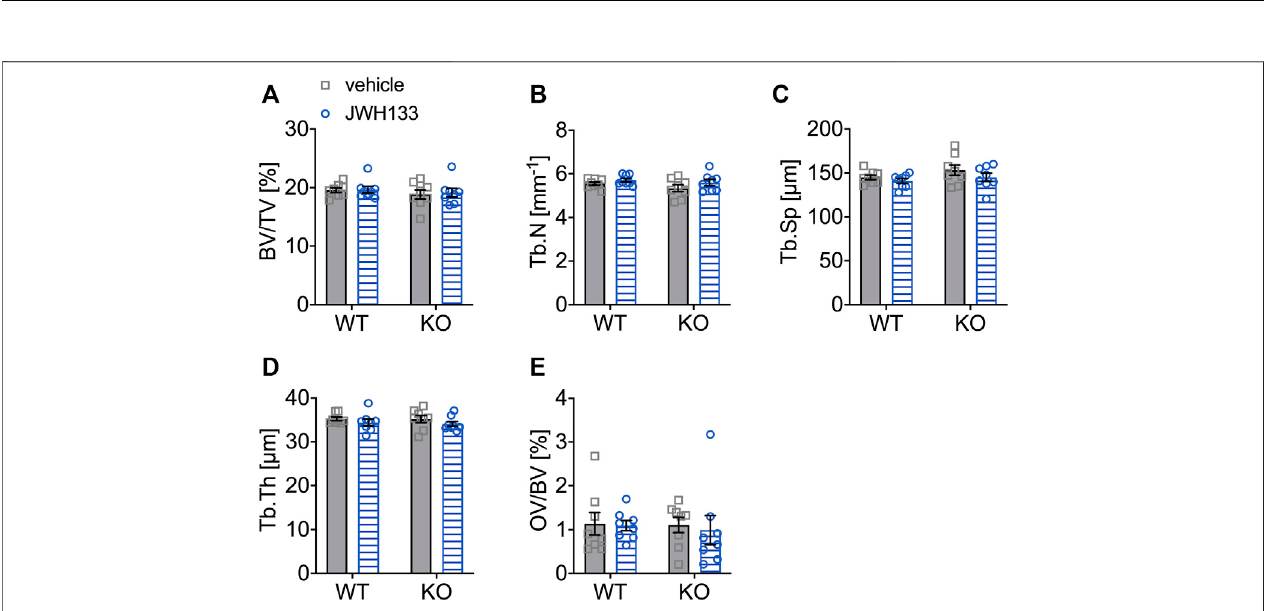
FIGURE 8 | Structural bone parameters were not affected by a 4-week treatment with JWH133 in aged mice. (A) Bone volume per tissue volume (BV/TV) was similar between WT and p62 KO mice and showed no effect of treatment. (B) Trabecular number (Tb.N) was comparable between genotypes and treatment. (C) Trabecular spacing (Tb.Sp) showed no difference between genotype or treatment. (D) Trabecular thickness (Tb.Th) was comparable for genotype and treatment. (E) Osteoid volume per bone volume (OV/BV) was similar in p62 KO and WT mice and not in fl uenced by the treatment with JWH133. Data were analyzed by using ordinarytwo-wayANOVA.Allerrorbarsshowmean±SEM.Squaresandcirclesrepresentindividualdatapoints.WTvehicle N =8,KOvehicle N =8,WTJWH133 N =8, KO JWH133 N = 8.